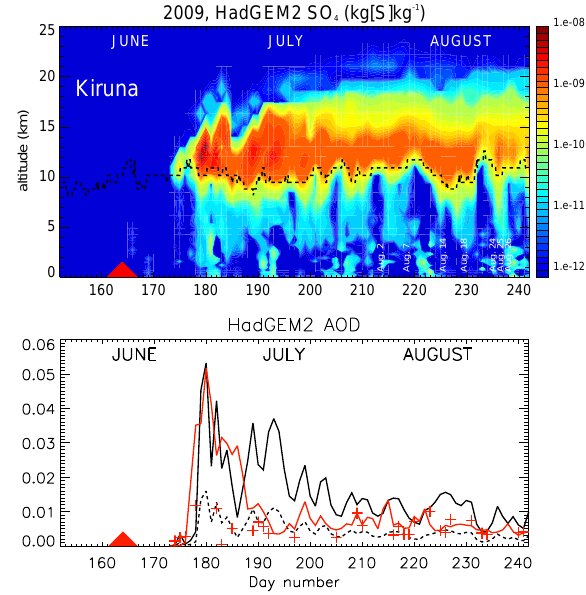
Fig. 7. Evolution from June to August 2009: SO 4 (top) and AOD at 550nm (bottom black line) and 750nm (bottom black dashed line) over Kiruna modelled by the HadGEM2 climate model. Evo- lution from June to August 2009: AOD at 550nm over OHP sta- tion modelled by the HadGEM2 climate model (bottom red line) and observed by the lidar from the tropopause to 20km (bottom red crosses). The dates of the STAC flights are indicated in white in the upper panel. The black dashed line is the model thermal tropopause. The Sarychev eruption is symbolized by the red